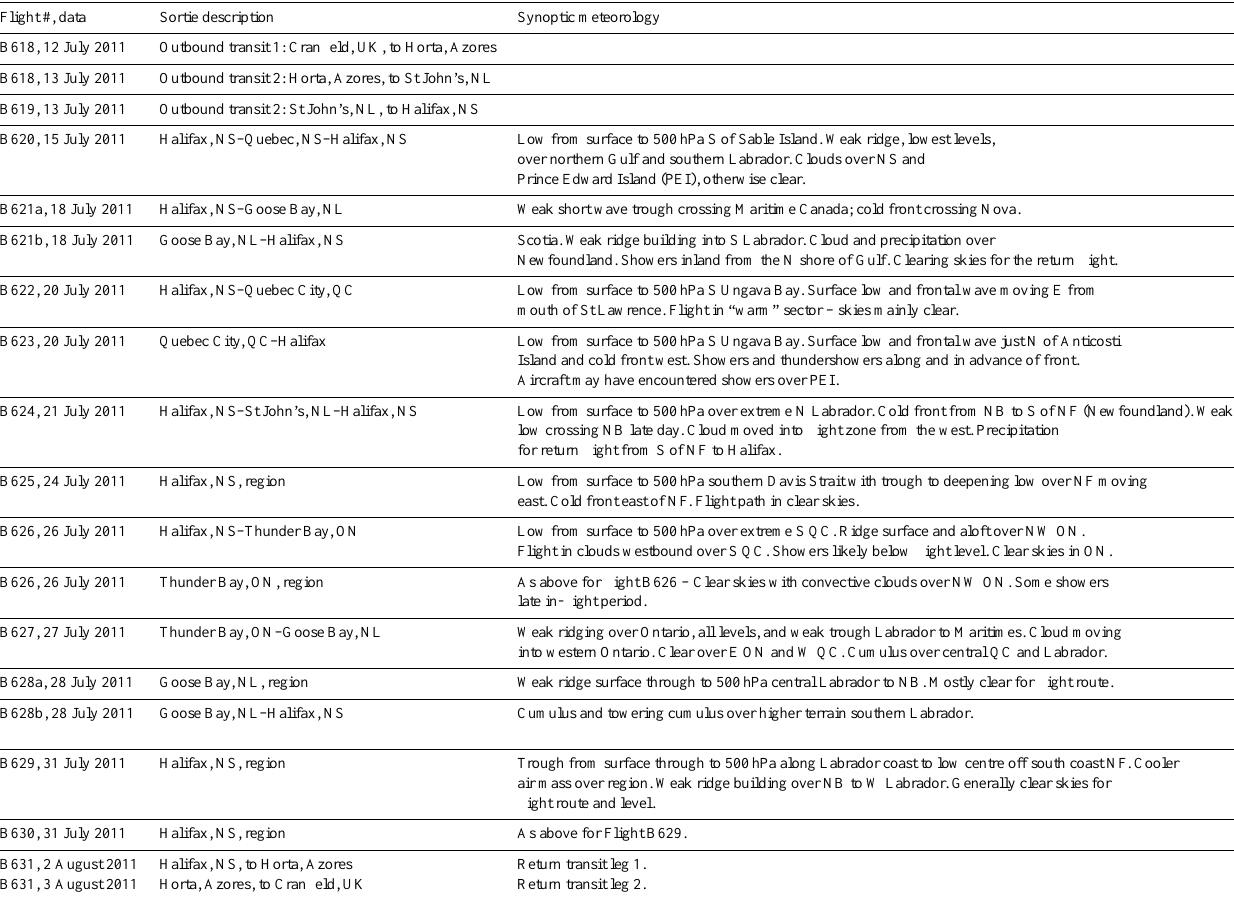
Table 1. Synoptic meteorology and weather associated with BORTAS flights over Canada.